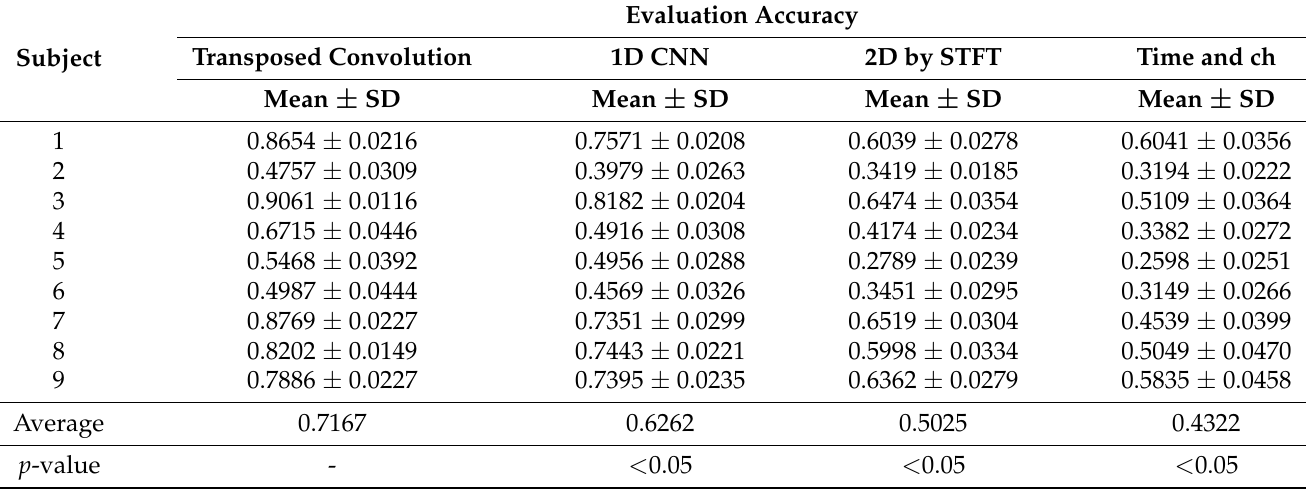
Table 6. Unseen evaluation data accuracy.